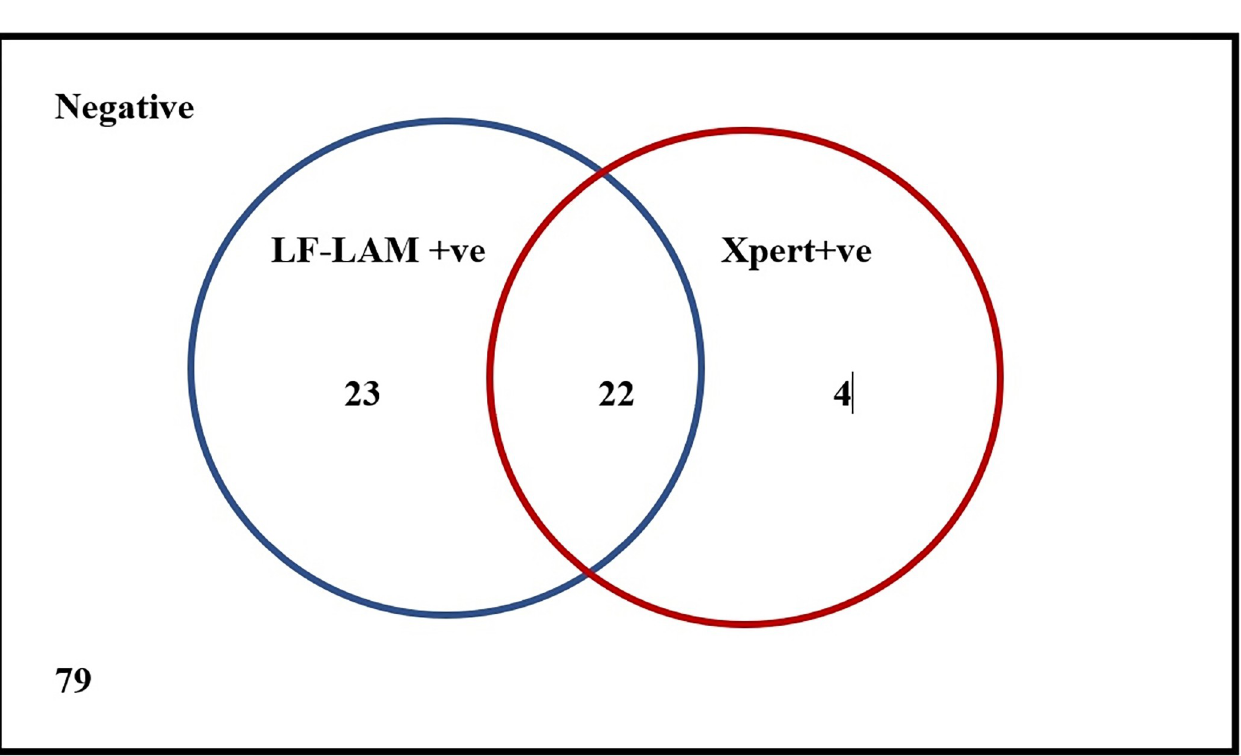
Fig 1. Venn diagram depicting positivity by urine LF-LAM and sputum Xpert among 128 symptomatic patients.